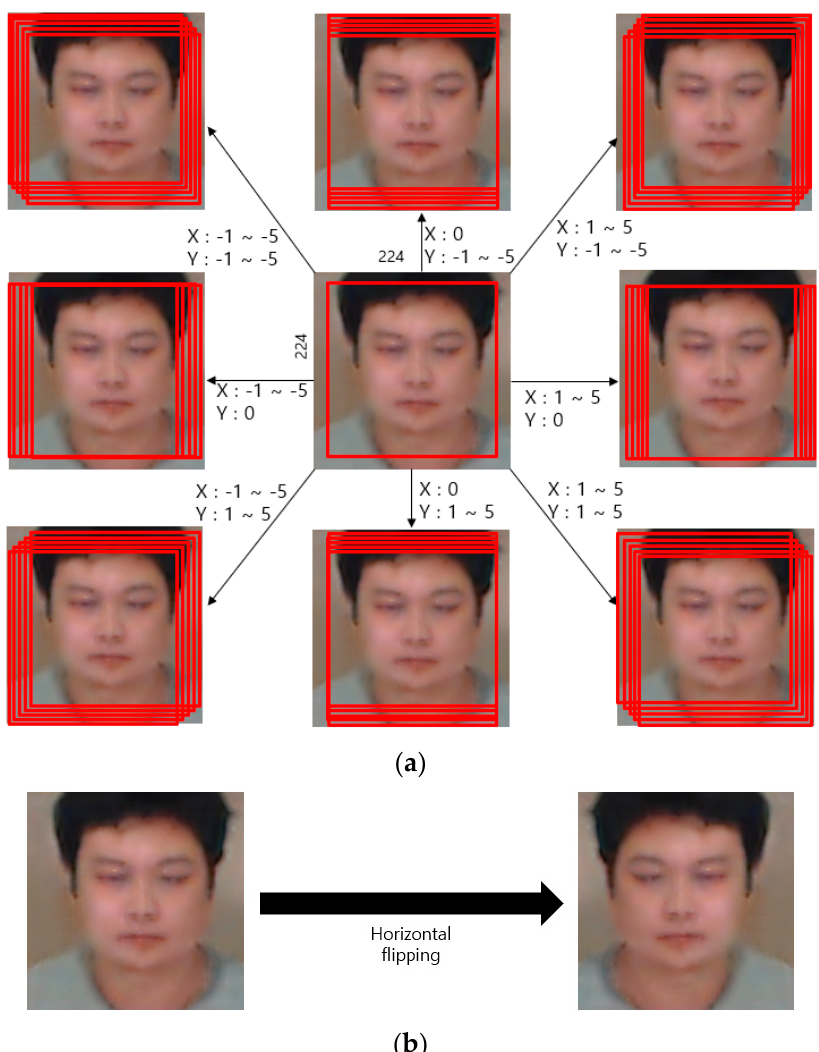
Figure 5. Method for data augmentation including ( a ) cropping and image translation, and ( b ) horizontal flipping.